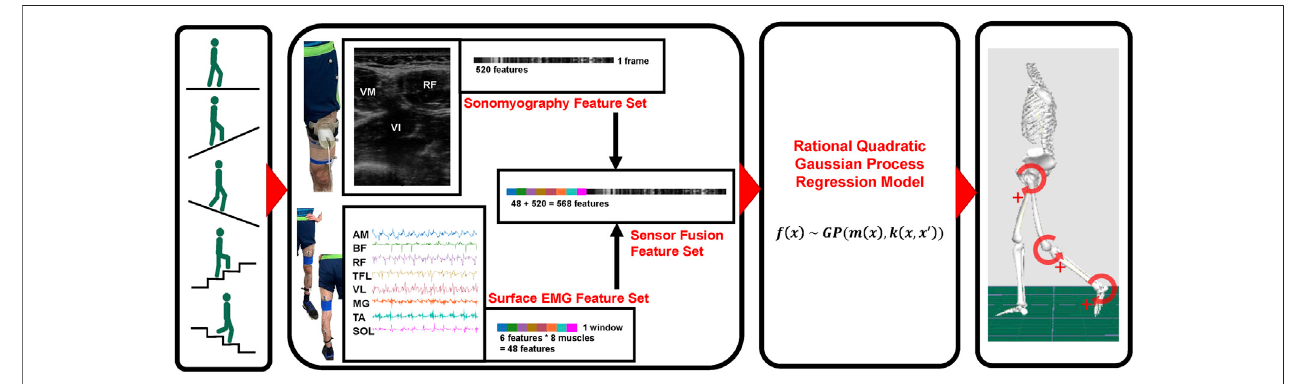
FIGURE 1 | Schematic representation of methods. Beginning with data collection during fi ve ambulation modes, sensing modality [sonomyography, surface electromyography (EMG) and sensor fusion] feature generation, regression model implementation, and ultimate hip, knee and ankle joint kinematic prediction.